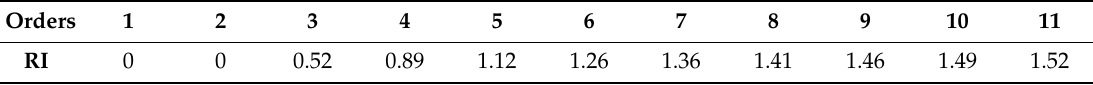
Table 4. Reference table for the RI value of the average random consistency index [49].